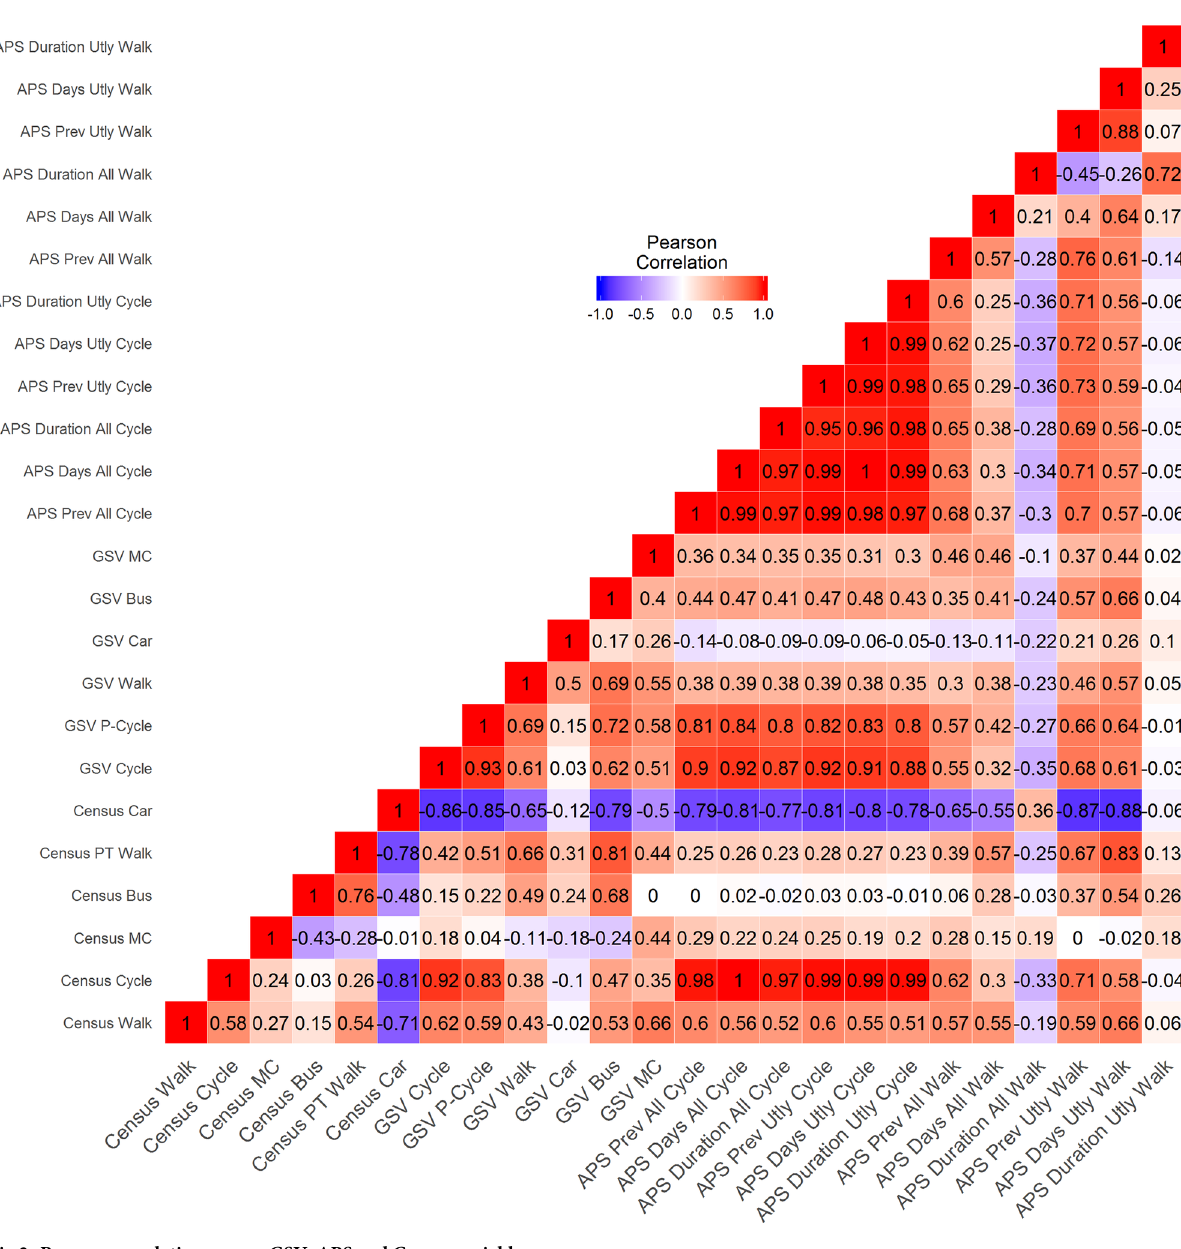
Fig 2. Pearson correlation among GSV, APS and Census